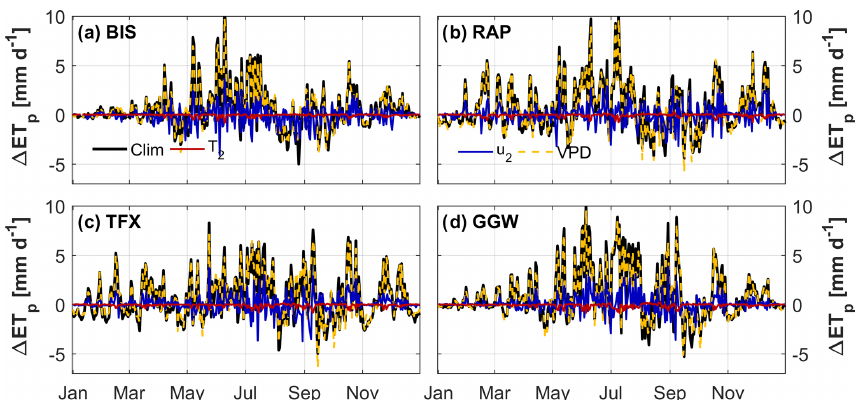
Figure 6. Change of ET p compared to estimated ET p of 2017 ( (cid:49) ET p ) for (a) Bismarck, ND; (b) Rapid City, SD; (c) Great Falls, MT; and (d) Glasgow, MT. (cid:49) ET p is calculated by using the climatological averages of T 2 , u 2 , and VPD, respectively, instead of 2017 values, while “Clim” corresponds to ET p calculated from the climatology. (cid:49) ET p values were smoothed by applying a 10-day running